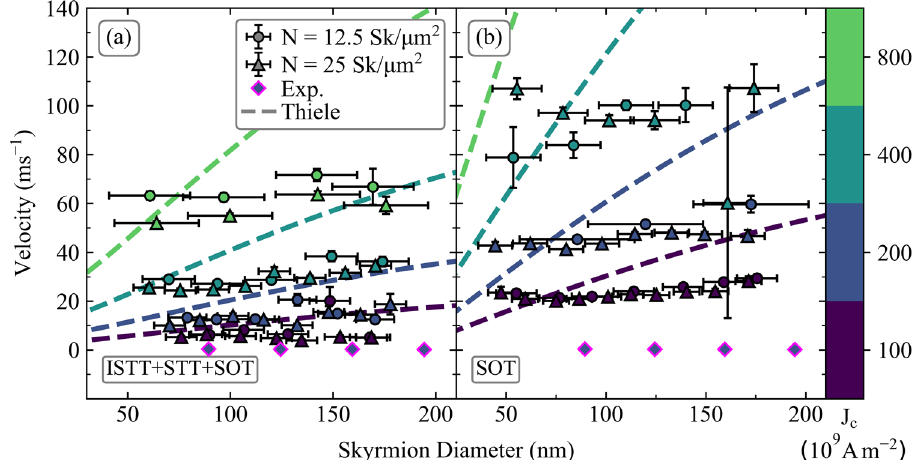
Figure 5. Skyrmion velocity diameter dependence. ( a ) Shows results for skyrmions under the influence of ISTT + STT + SOT and ( b ) shows the influence of SOT alone. The solid disks and triangles represent N = 12.5, and N = 25 Sk/µm 2 respectively, each corresponding to an applied current density shown by the colour bar. The magenta outlined diamonds represent the experimental results. The coloured dashed lines show the solutions obtained from the Thiele model with α = 0.1, for an isolated skyrmion at the respective current density, using the same color